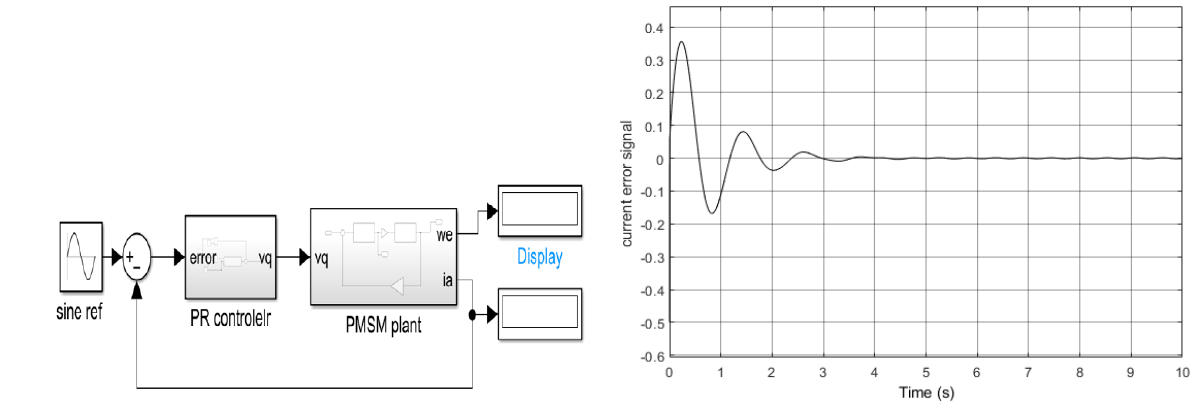
Figure 3. Simulink model of the closed loop PR controller and current error signal waveform for the selected gains.